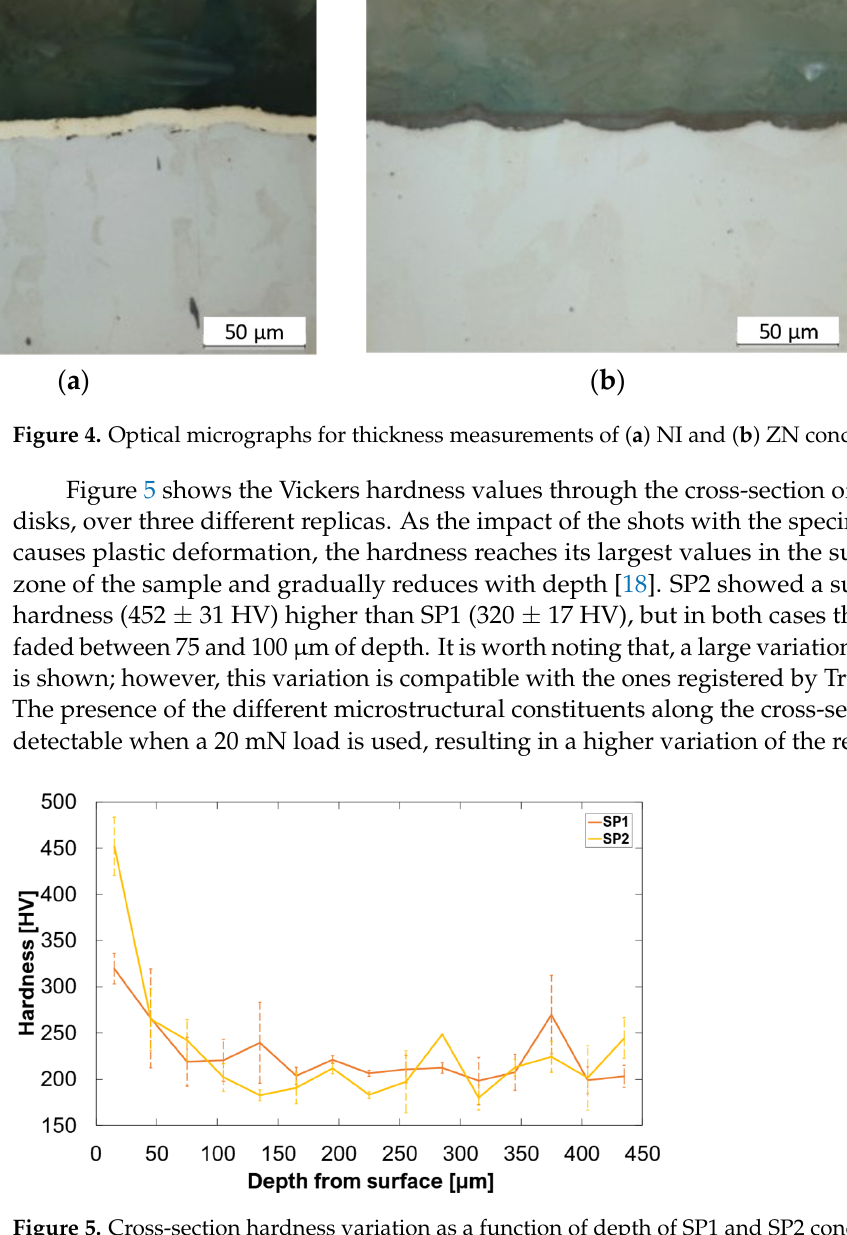
Figure 4. Optical micrographs for thickness measurements of ( a ) NI and ( b ) ZN conditions. Table 3. Roughness values ( 𝑅𝑎 ) of the disks and thickness values ( 𝑡 ) of the galvanizing treatments. Conditions